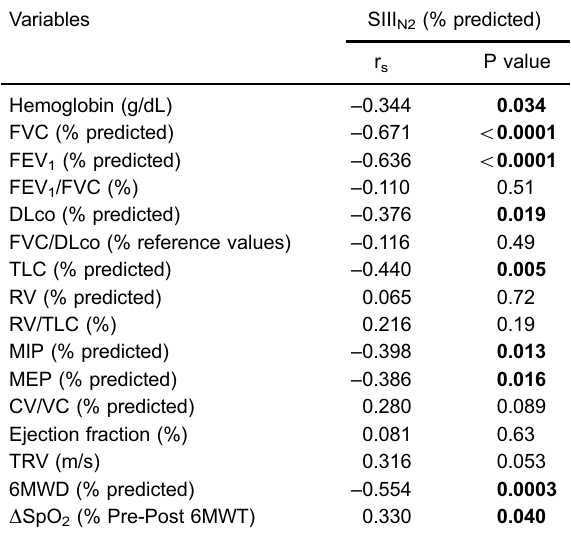
Table 3. Spearman ’ s correlation coef fi cients of phase III slope of the nitrogen single-breath washout test with hemoglobin, lung function, echocardiography and functional capacity parameters of patients with sickle cell